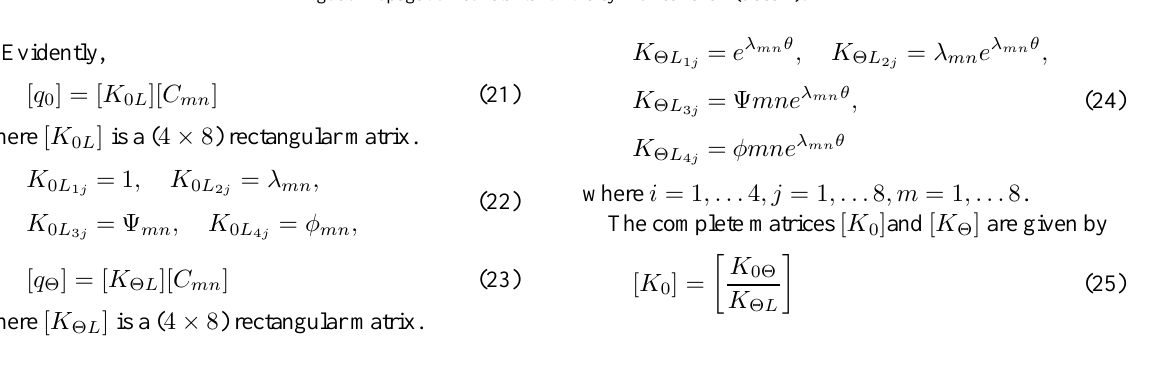
Fig. 3. Propagation constants for the cylindrical shell (Case